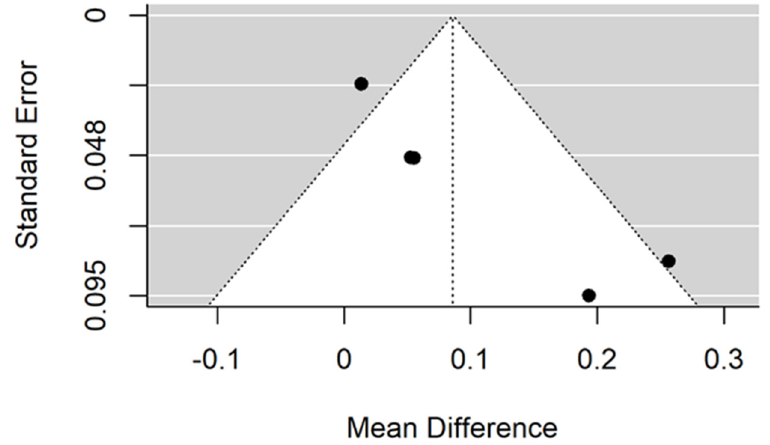
Figure 13. Funel plot for evalutaion of thread shape factor infulence on pull-out strentght in animal bone model studies.